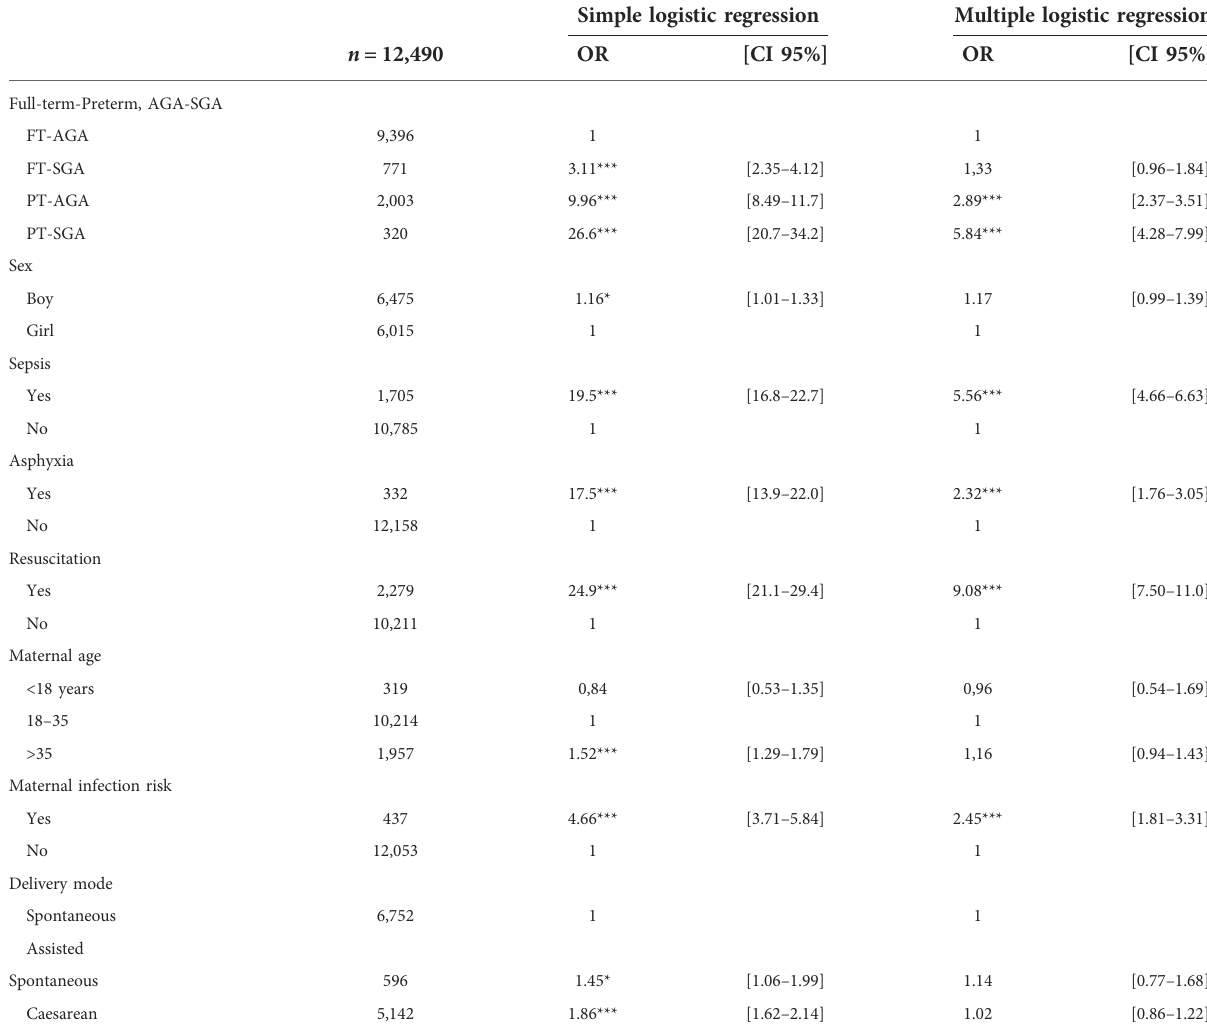
TABLE 2 Simple and multiple logistic regression analysis on overall risks of respiratory